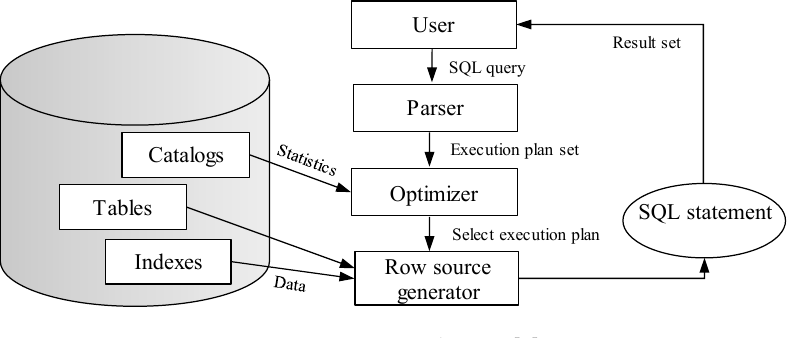
Figure 3. Query evaluation [1].